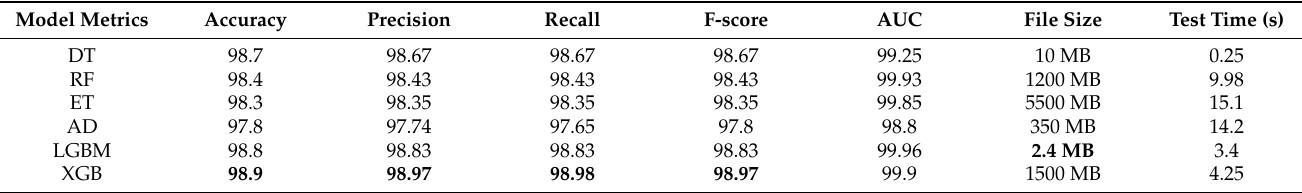
Table 6. Performance evaluation of the trained models on CSE-CICIDS2018 dataset, showing the time for prediction and model size.